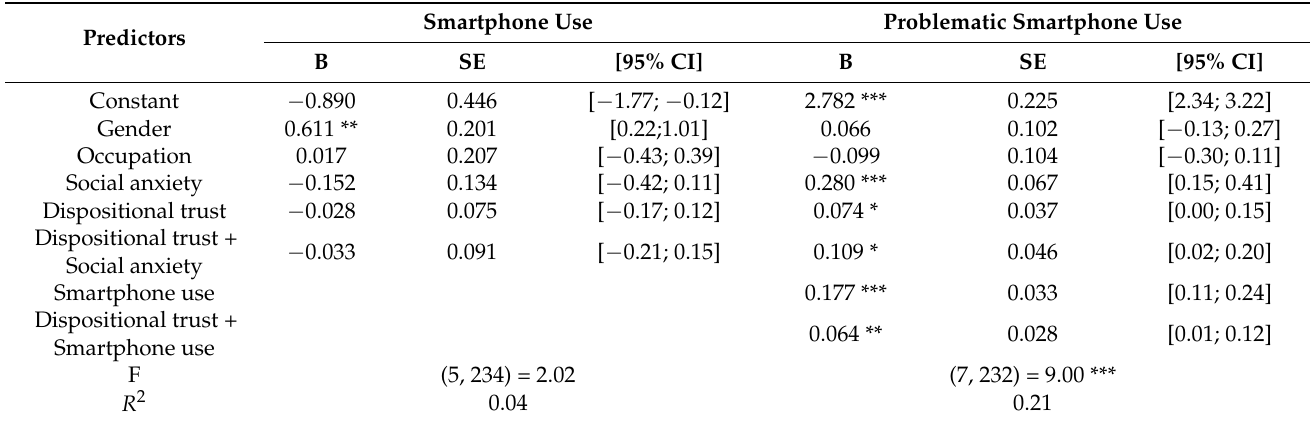
Table 2. Regression results for the moderated mediation